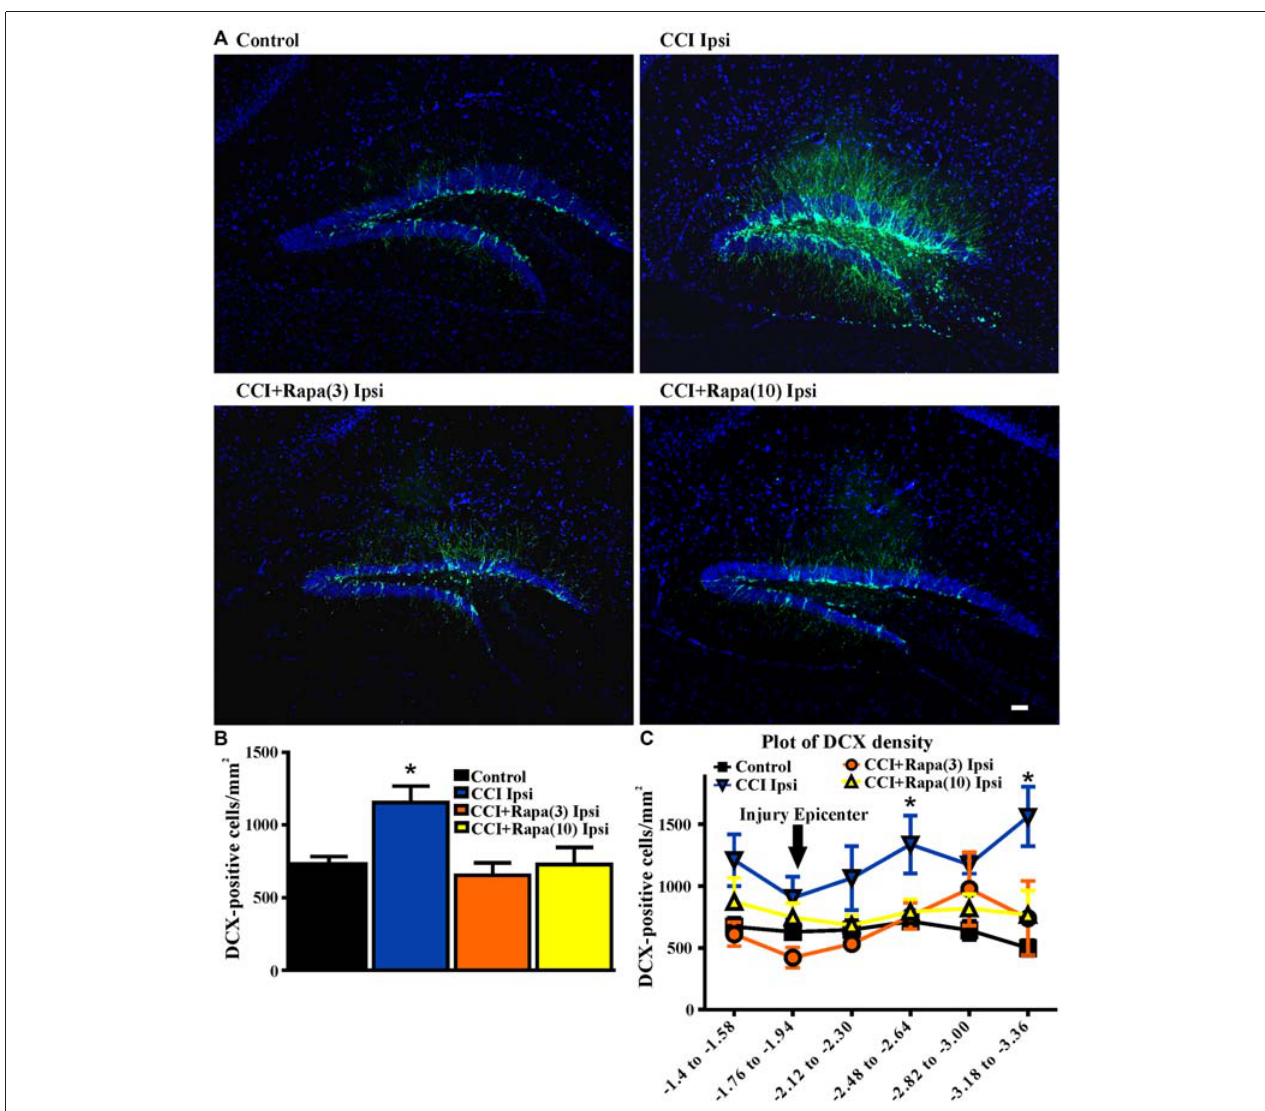
FIGURE 3 | Doublecortin (DCX) immunolabeling in dentate gyrus 14 days after injury in mice from control, CCI-injured, and CCI-injured with rapamycin groups . (A) Representative images of DCX expression from four treatment groups: control, CCI Ipsi, CCI + Rapa(3) Ipsi, and CCI + Rapa(10) Ipsi. (B) Mean DCX expression in control, CCI Ipsi, CCI + Rapa(3) Ipsi, and CCI + Rapa(10) Ipsi groups. Ipsilateral CCI exhibited greater DCX-positive cell density compared to controls. The injury-induced increase in DCX-positive cell density in CCI ipsi mice was not observed in either CCI + Rapa treatment group. (C) DCX-positive cells/mm 2 as a function of distance from bregma along septo-temporal axis of hippocampus. Scale bar indicates 0.1 mm. Error bars indicate SEM; ∗ p < 0.05.